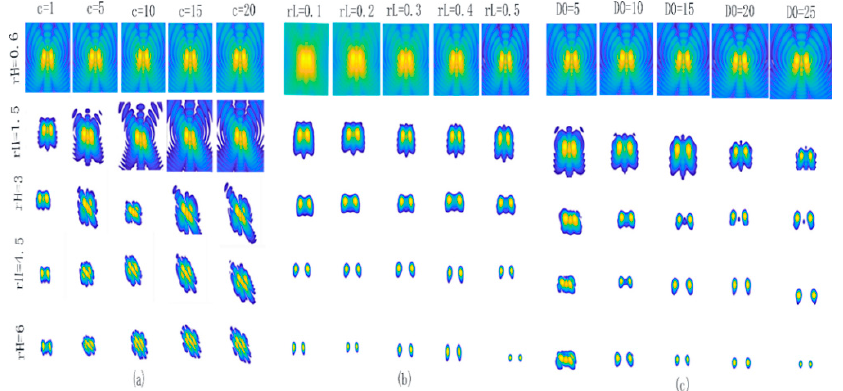
Figure 3. The image representation of the homomorphic filter for five di ff erent r H values for two dipole sources at 3 GHz. ( a ) Against five di ff erent c values, ( b ) against five di ff erent r five di ff erent D 0